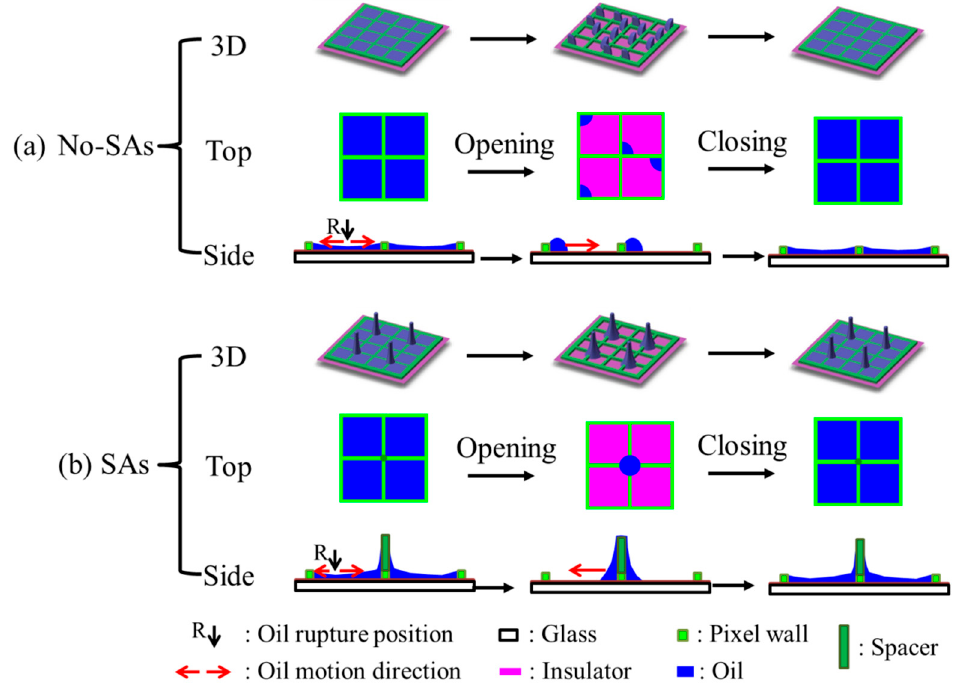
Figure 6. Schematic of the opening and closing processes of EWD devices without ( a ) and with ( b ) spacer arrays (SAs) at 3D, top, and side views. The pixels without SAs were named as No-SAs pixels, while pixels with SAs as SAs pixels. R position is position of oil film rupture occurs. Red arrows at the side view show the oil motion directions during opening or closing of EWD devices.